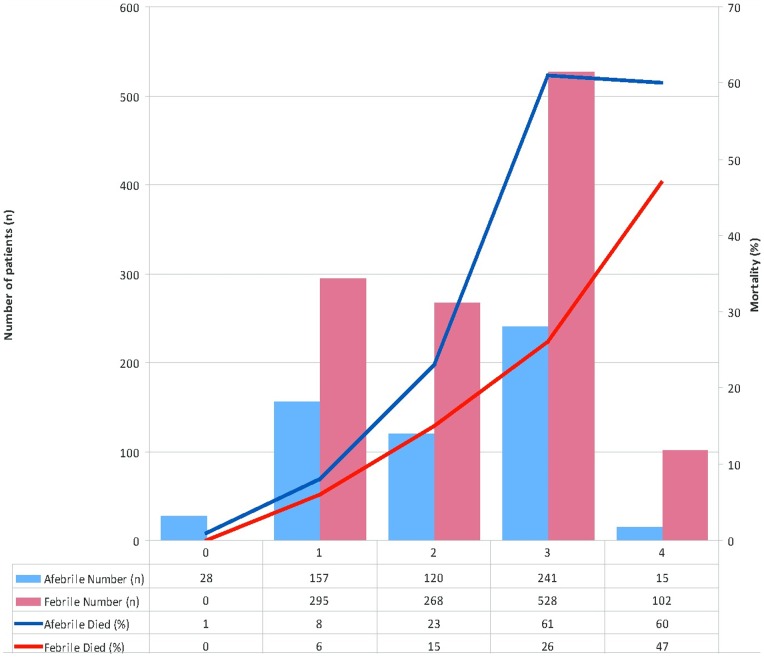
Relationship between fever and in-hospital mortality, stratified by disease severity (RCAM score).Febrile: tympanic temperature ≥37.5°Celsius, RCAM: as defined and calculated in table 1.